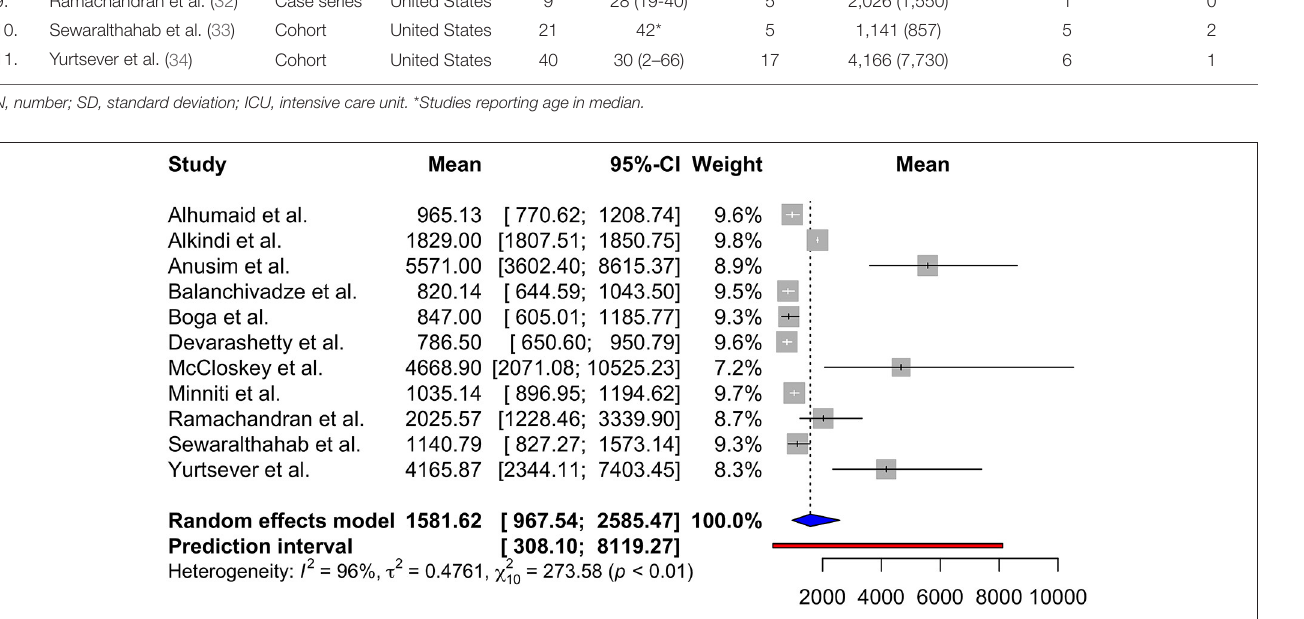
effect size and objectively by Egger’s test. The Galbraith plot was used to detect the presence of outlier studies